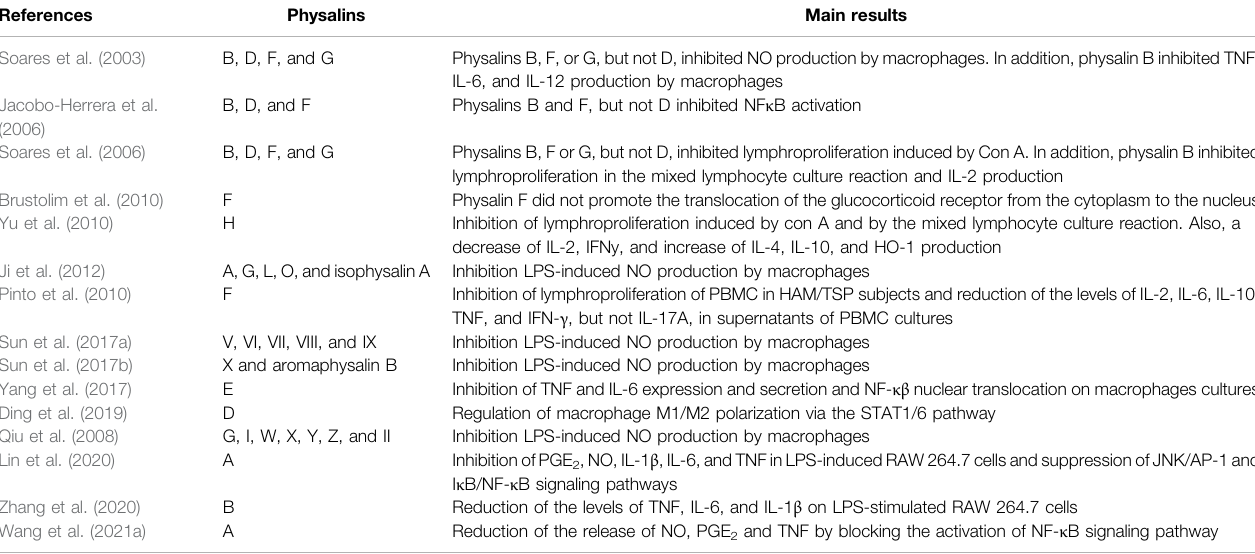
TABLE 1 | In vitro immunomodulatory activity of physalins.